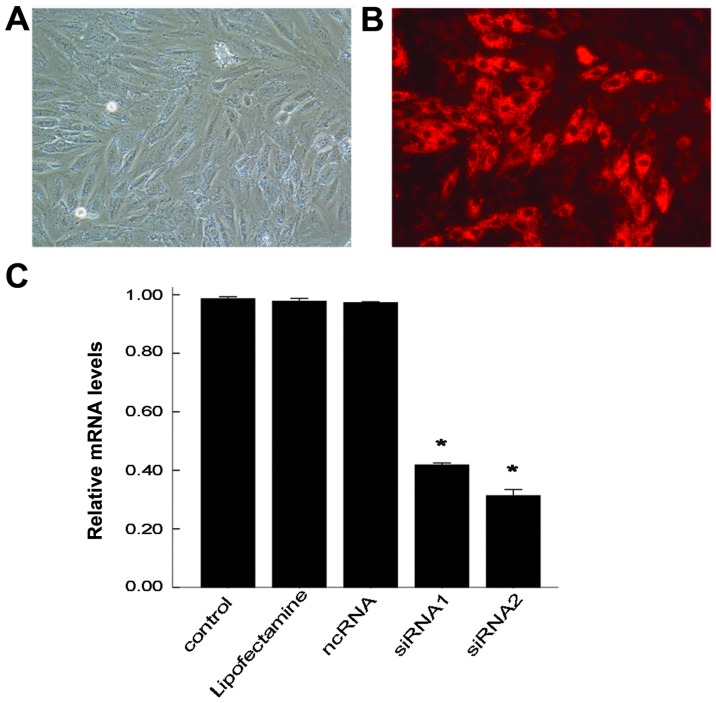
The transfection and knockdown efficiency of siRNA against UCP2 in H9C2 cells. (A and B) H9C2 cells transfected with control siRNA (Cy3) emitted red fluorescence. The transfection efficiency is expressed as the ratio of the number of red fluorescence cells over all cells by fluorescence microscopy (magnification, x20). (C) The knockdown efficiency of siRNA against UCP2 in H9C2 cells. H9C2 cells were left untransfected (control), transfected with Lipofectamine 2000 (no siRNA), transfected with negative control siRNA (ncRNA), or transfected with siRNA1 or 2. After 24 h, the mRNA levels of uncoupling protein 2 (UCP2) were determined by RT-qPCR with normalization to 18s RNA. *P<0.05 vs. control.